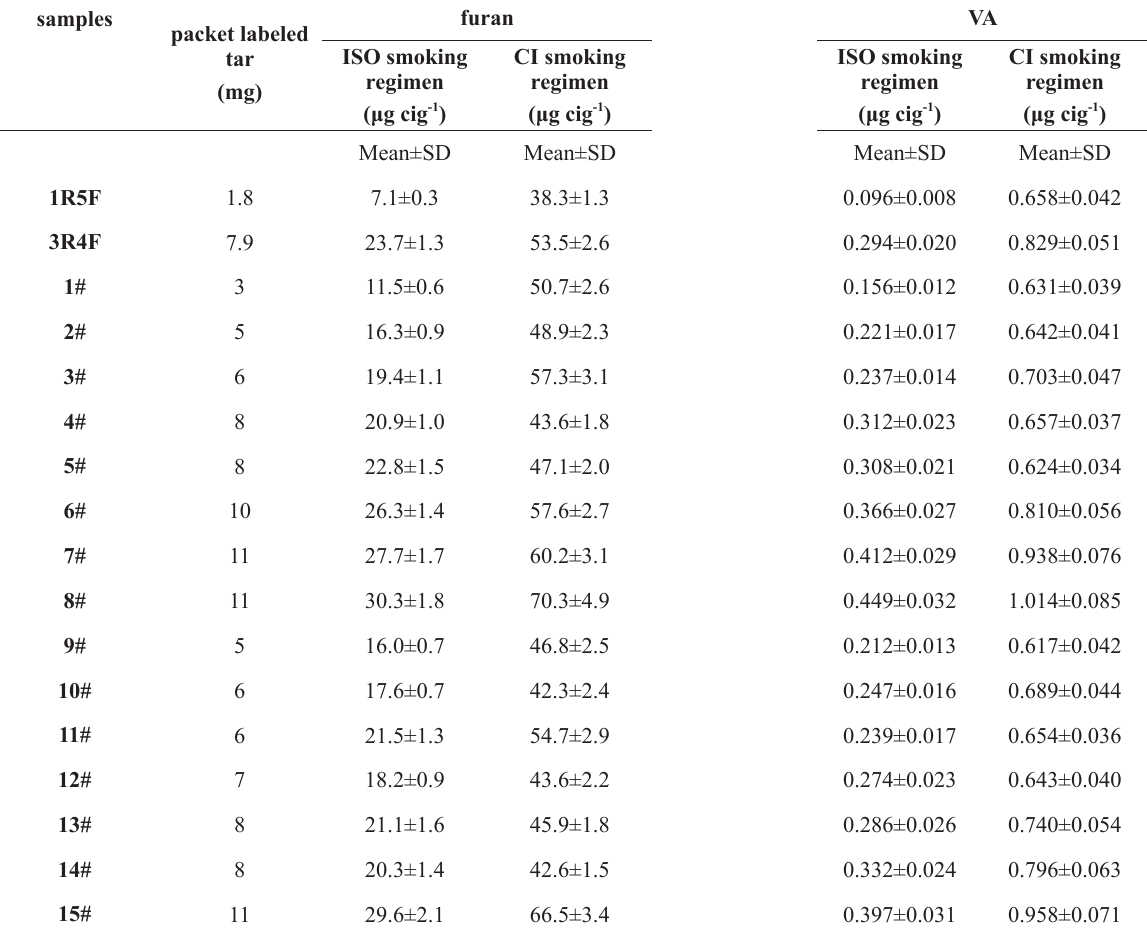
Furan and VA yields in vapor phase of mainstream cigarette smoke samples under ISO and CI smoking regimens (n=3). samples packet labeled